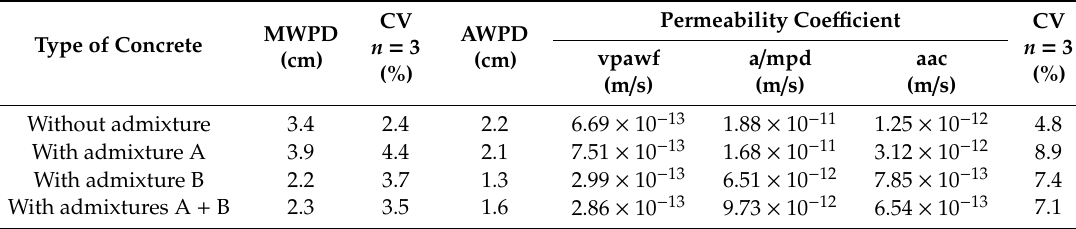
Table 3. The test results of the water penetration depth and the calculated values of the permeability coefficient.